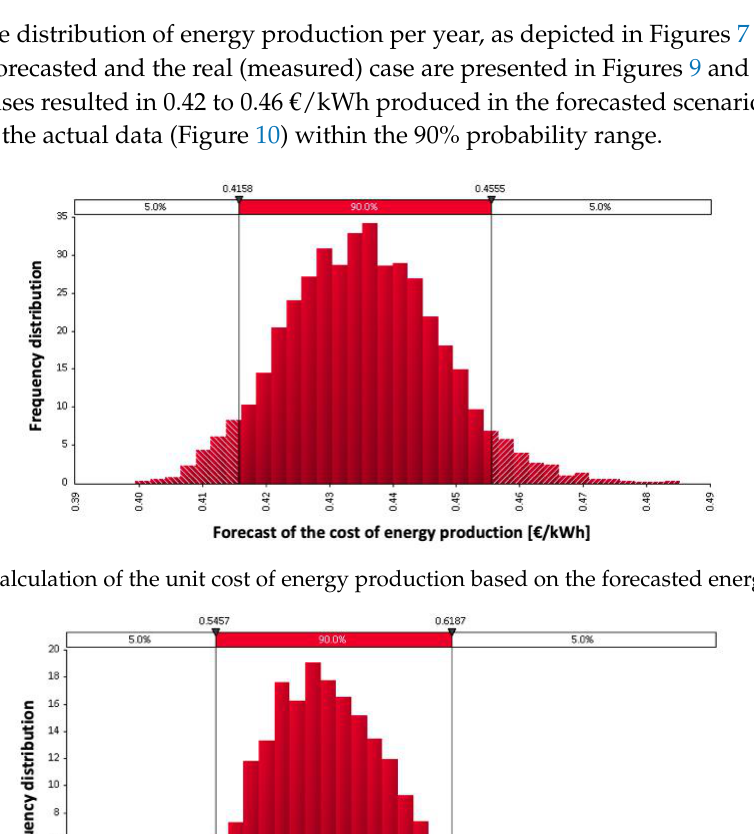
10 of 14 Figure 8. Total annual measured energy produced by the PV array. The descriptive statistics of the simulated results for both the forecasted and the actual scenarios are provided in Table 3. Table 3. Descriptive statistics of the total annual energy produced by the PV array (kWh/y). Statistics